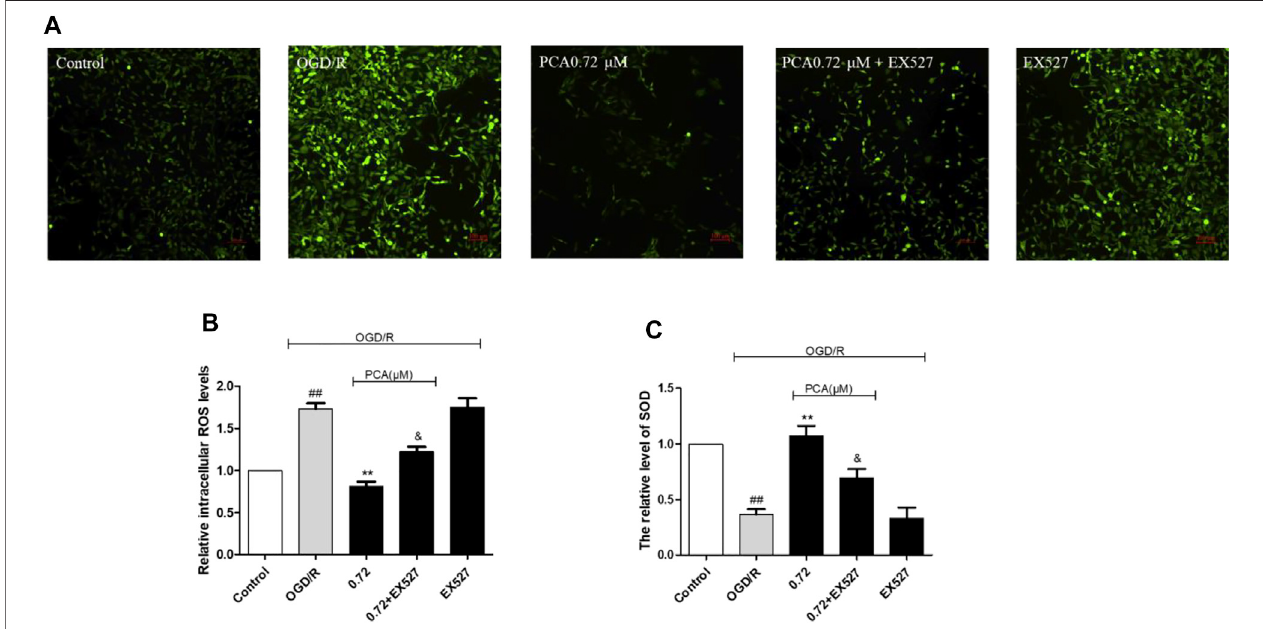
FIGURE 8 | Inhibition of SIRT1 by EX527 attenuates the antioxidant activity of PCA. (A, B) Quantitation of HUVECs ROS level was shown. (C ) Quantitation of HUVECs SOD activity was shown. The values are expressed as the mean ± SD ( n = 3). ## p < 0.01 vs. Control, ** p < 0.01 vs. OGD/R. & p < 0.05 vs. PCA 0.72 μ M.